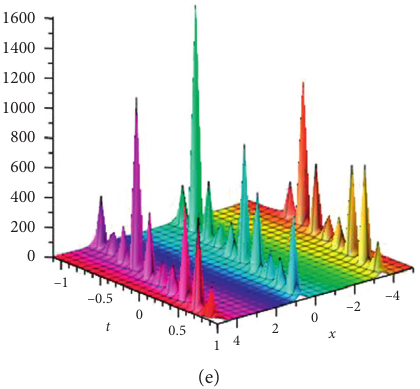
Figure 5: 3D profile of Family 17 with α � 1 . 5 � σ , β � 0, k � y � 1, ω � 0 . 5, p � q � 0 . 9, μ � 0 . 25, and A � 2 . 5. (a) | Φ | . (e) | Φ | . (d) | Φ 24 25